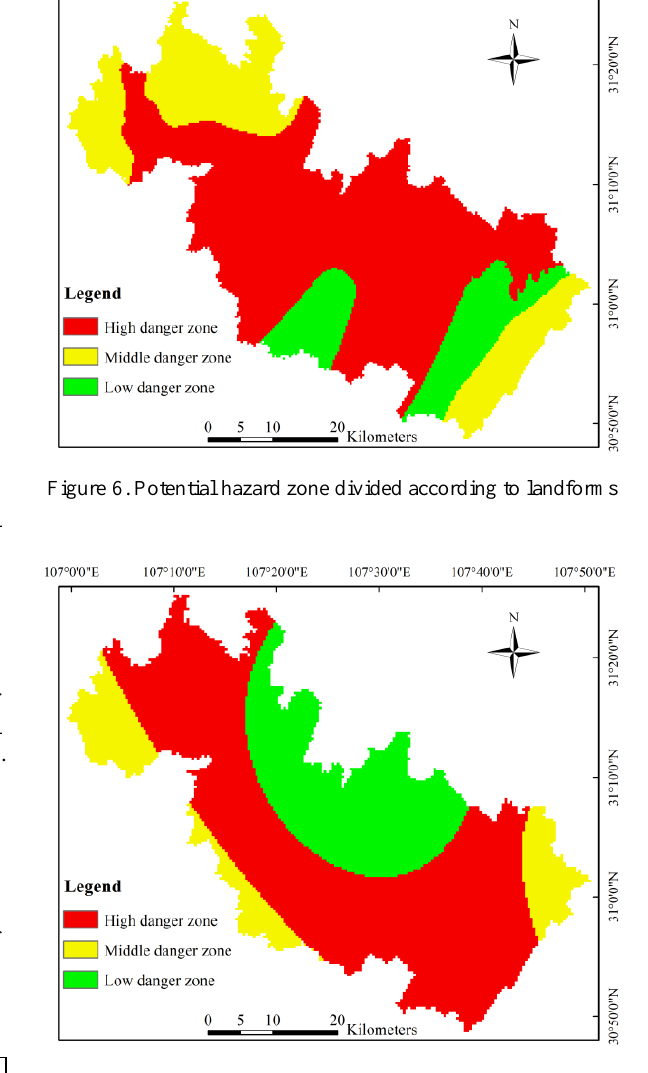
Figure 7. Potential hazard zone divided according to annual